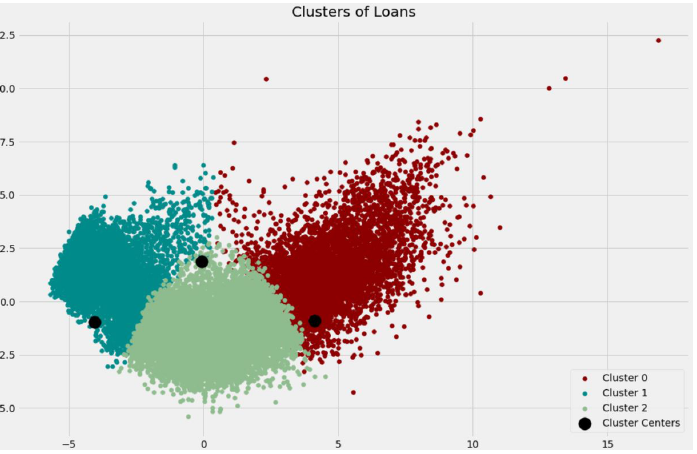
Figure 7. Visual representation by the PCA method of the three clusters present in this data